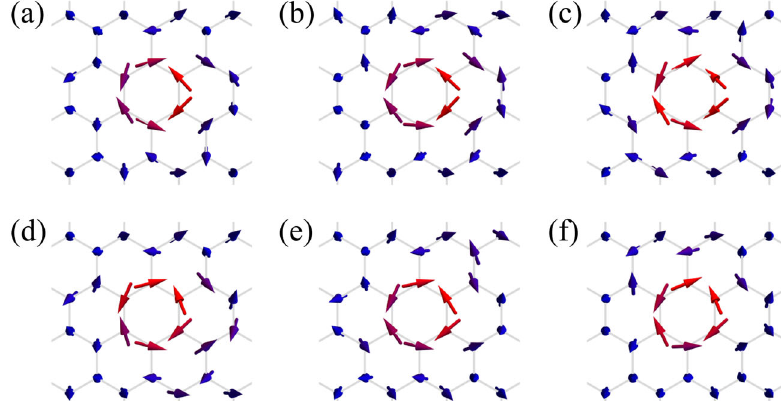
Fig. 9 Vortex dynamics. Subplots a – f resemble the spin con fi guration in the vicinity of a vortex at times t = 0.0, 2.5, 5.0, 7.5, 10.0, and 12.5, respectively. Thermally excited defects propagate, yet the vortex itself remains localized under time evolution. See Supplementary Video for an animation.